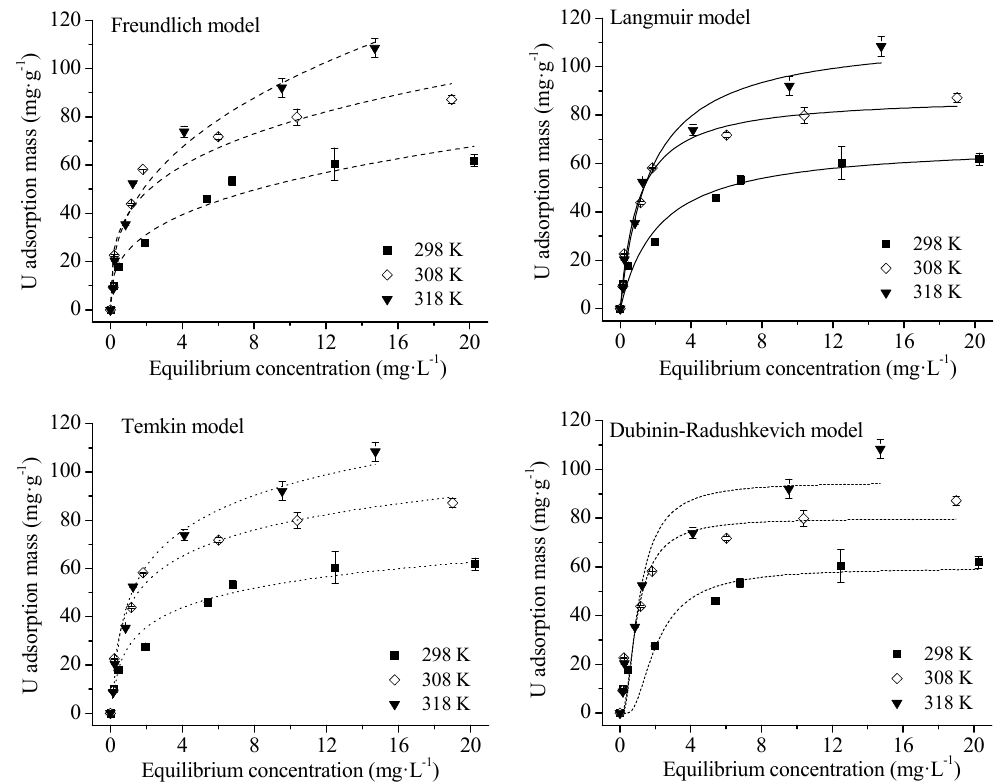
Figure 4. Isotherms of U(VI) adsorption onto HA at different temperatures. Experimental conditions: adsorbent mass: 20 mg; solution volume: 30 mL; U(VI) concentration: 0, 5, 10, 20, 40, 60, 80, 100 mg/L; contact time: 6 h; initial pH = 3.0; equilibrium pH: 2.60–2.90.